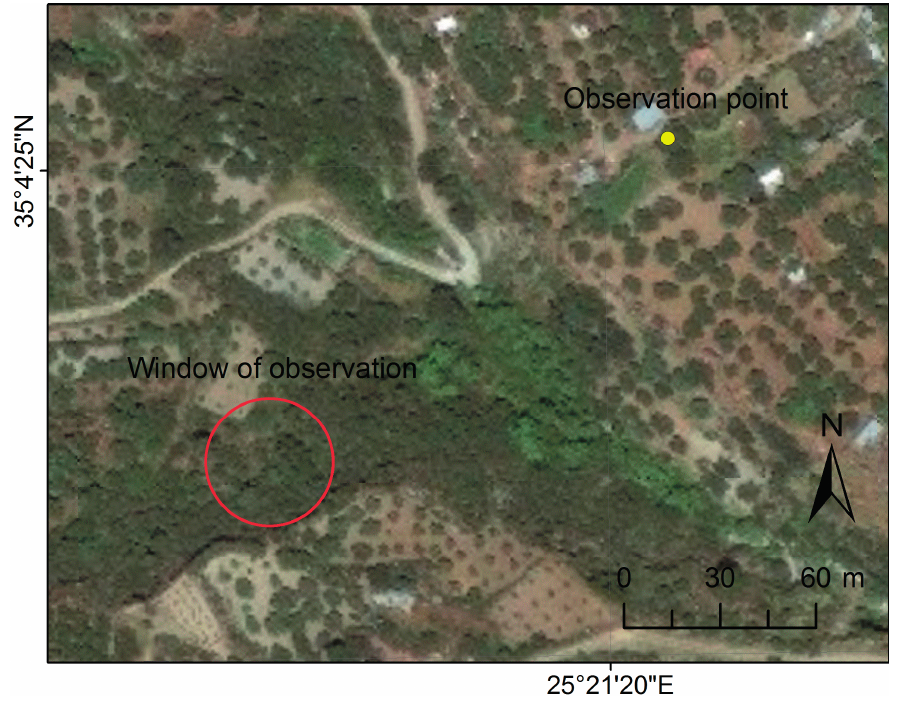
Figure 17. In a characteristic case in Herakleon, the targeted point was classified as “Shrubland with sparse tree cover” (D10) by the LUCAS surveyors from remotely (>100 m), possibly based on use of EO data and knowledge of the local